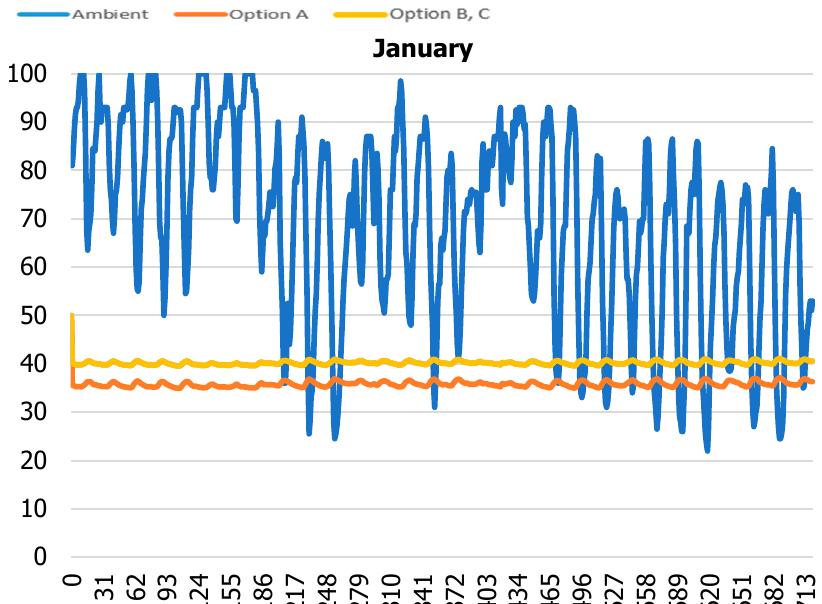
Figure 27. RH% comparison for the month of January. Note: option B and option C had the same relative humidity, with a value of 40%. The results for option B and option C are merged and displayed a single yellow line.